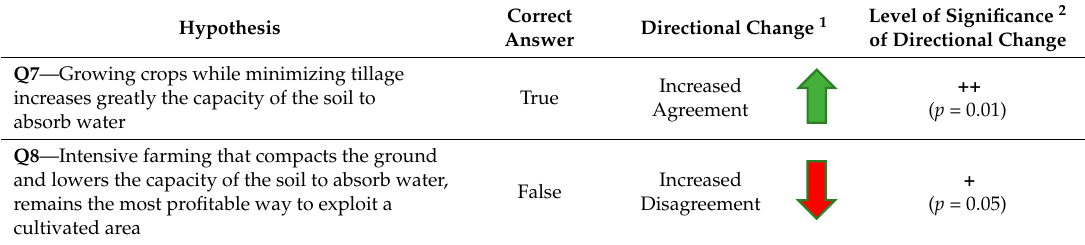
Table 2. Playing the game induces a directional change in the way participants confirm or reject the seven hypotheses. Table 2. Cont.